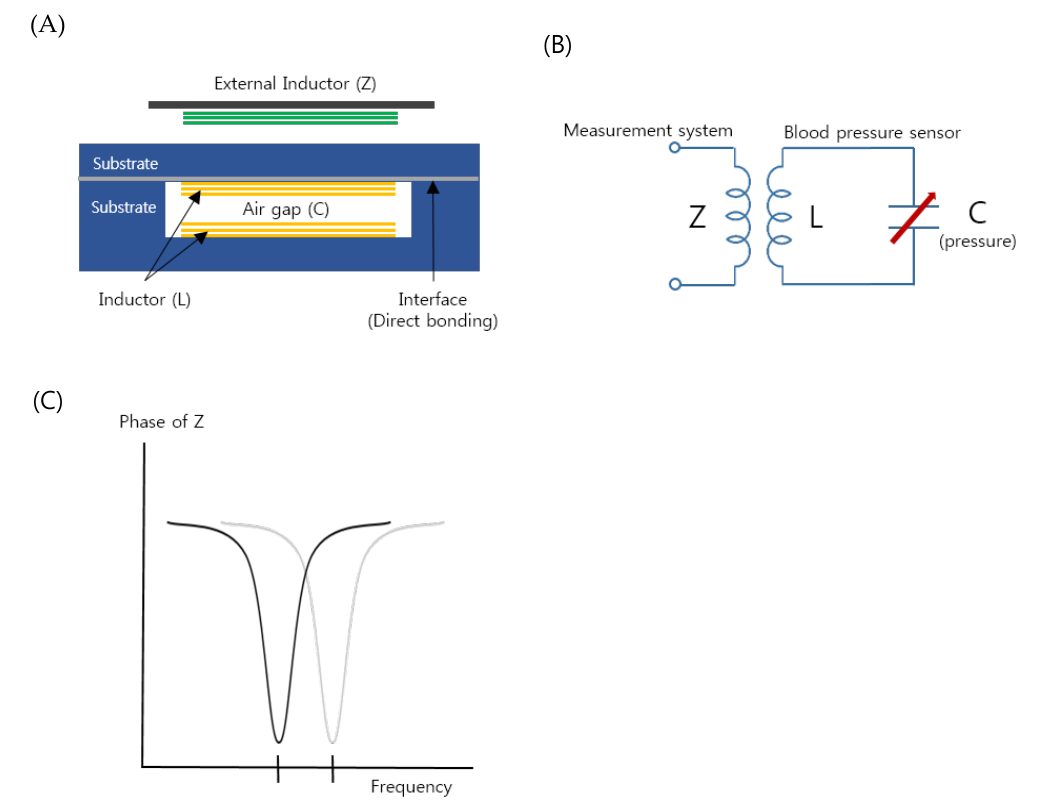
Figure 1. ( A ) Schematic of the proposed implantable blood pressure sensor with two micro-inductors with an air gap working as a capacitor. ( B ) Equivalent circuit of the implantable blood pressure sensor. ( C ) Variation of the sensor resonance frequency by increasing pressure (in vascular).